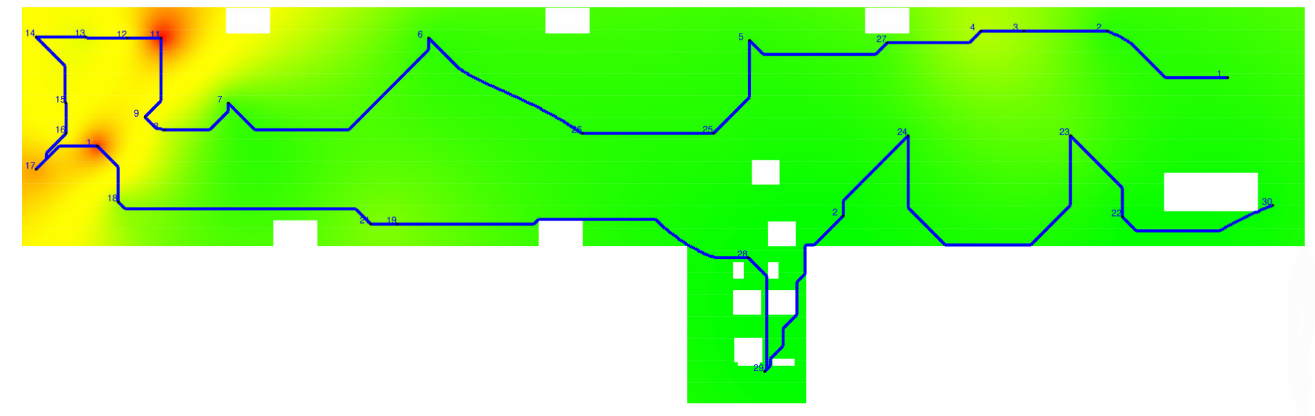
Figure 8. Radiation map and the optimal route for the movement of a dosimetrist in control room building No. 2 with visits to specified points. Table 3. Using interpolation